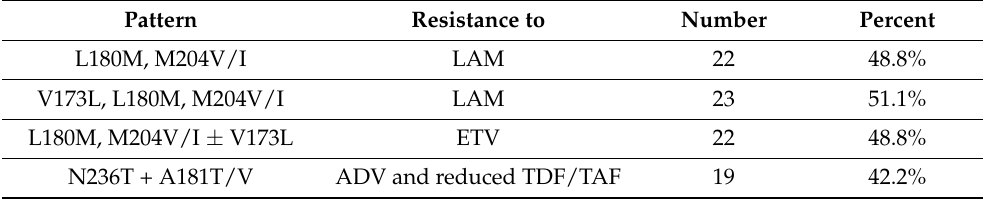
Table 4. HBV drug resistance pattern among 45 HIV–HBV co-infected genotyped patients. Pattern Resistance to